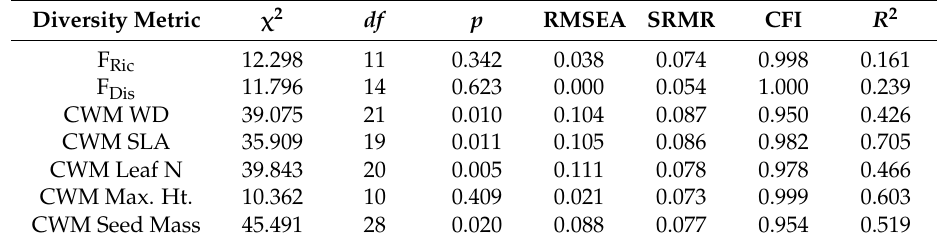
Figure 1. Path diagram for functional richness (F Ric ). Standardized path coefficients are given. R 2 values are total explained variance. Table 1. Path Analysis model results. Root mean square error of approximation (RMSEA) < 0.05, standardized root mean square residual (SRMR) < 0.08, and comparative fit index (CFI) > 0.95 indicate good fit.